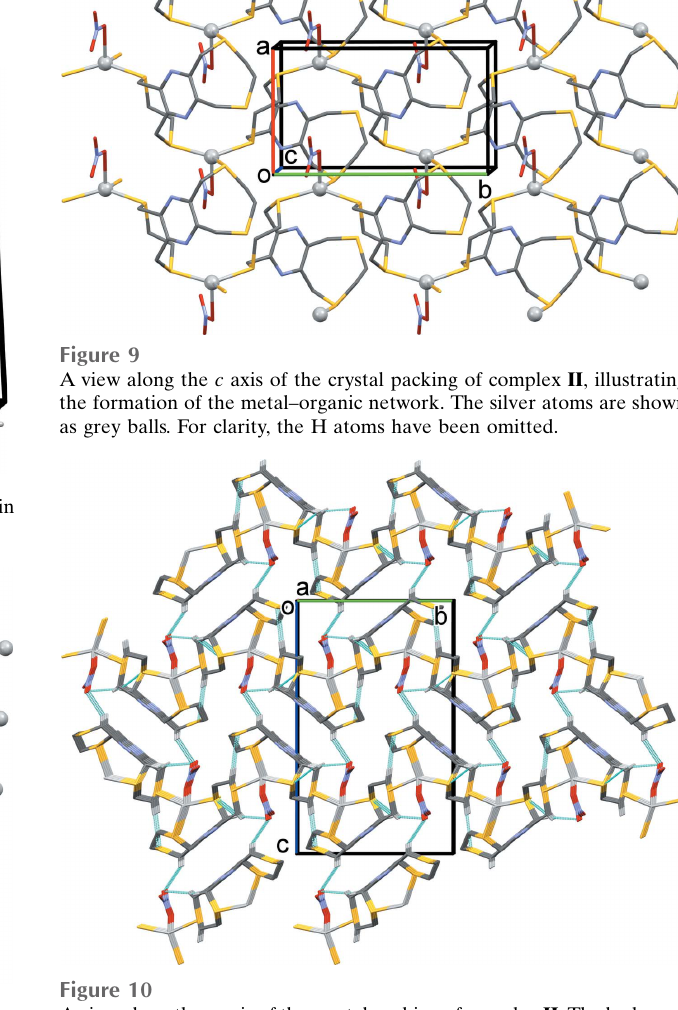
(Fig. 10 and Table 4).